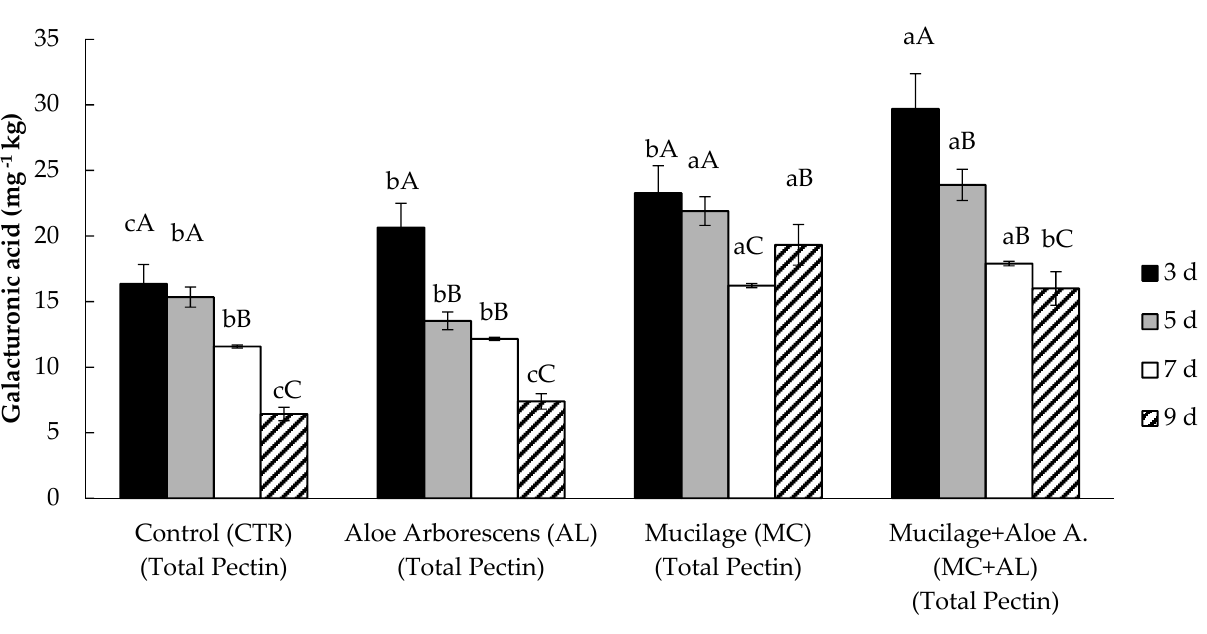
Figure 4. Total pectin (TP) of fruit slices of Actinidia deliciosa (Liang, Ferguson) coated with O. ficus-indica (OFI) mucilage (MC), or mucilage + A. arborescens (MC+AL), or A. arborescens (AL) not treated (CTR), just after being coated (0) and at 3, 5, 7, 9 days of storage at 5 °C. Different lowercase letters indicate significant differences between treatments at each sampling date. Different capital letters indicate significant differences between sampling date for the same treatment. Tukeys’ significant test was applied at p ≤ 0.05. Data are means ± S.E. (n = 3).